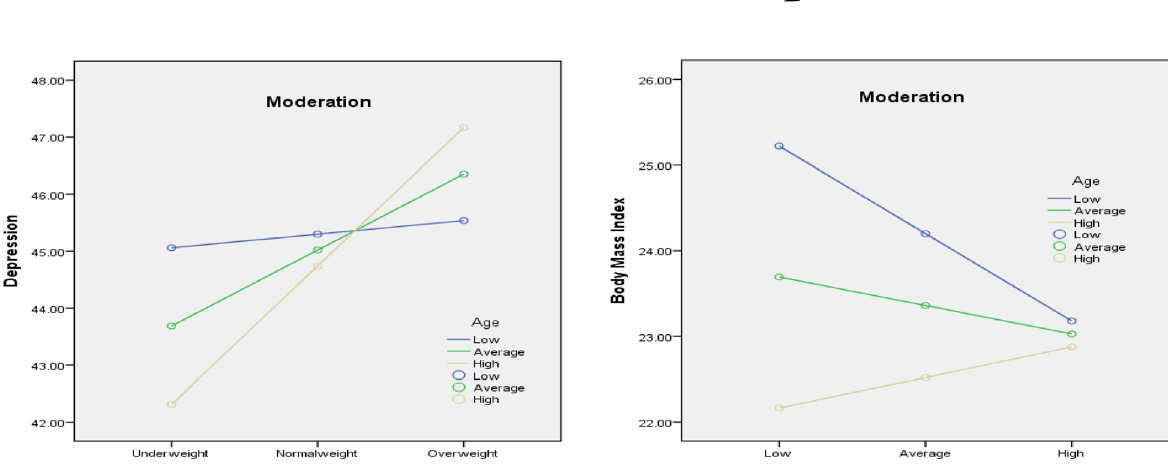
Fig. 5 A Proposed mechanism of the association between body dysmorphic disorder and depression mediated by BMI and moderated by age using template 58. The dashed arrows indicate non-significant effect, and solid arrows indicate significant effect(s). B The moderation effect of age on the relationship between Body mass index and body dysmorphic disorder. Simple slope analysis at average, above, and below the mean level of age. Low β -.4682, SE .1847, p < .05; Medium β -.1527, SE .1193, p < .05; High β .1628, SE .1615, p < .05. C The moderation effect of age on = = = = = = the relationship between BMI and depression. Simple slopes analysis at mean, above, and below the mean level of age. Low β p < .05; Medium β .3012, SE .1328, p < .05. High β .5485, SE .1909, p < = = = =